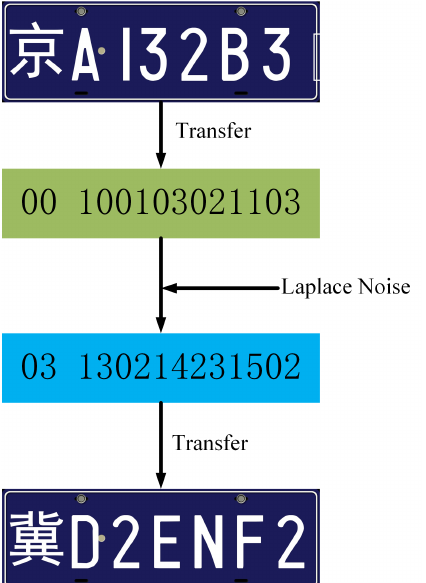
Figure 11. A new car plate content created by